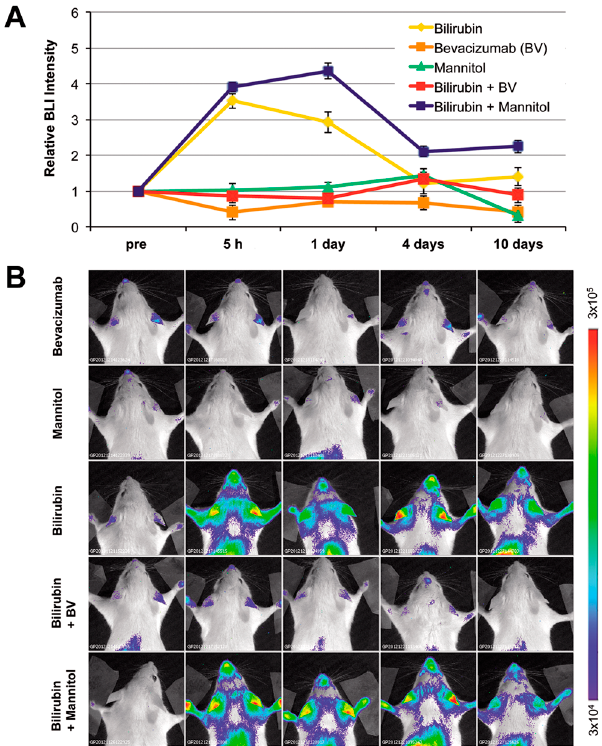
Figure 5. Effect of alteration of blood–brain barrier permeability. Before bilirubin administration, MITO-Luc mice were pretreated with mannitol (3 mL of 25% mannitol/100 g body weight) or bevacizumab (25 mg/kg body weight) and bioluminescence imaging analysis (BLI) was performed at different time points. ( A ) Quantification of BLI signals in selected regions of interest in the brain area. Statistical analysis revealed significant differences ( p ≤ 0.05) of the bilirubin group vs. bilirubin + bevacizumab group at the 5 h and 1 day time points; ( B ) BLI analysis of one representative animal out of five per group, at the different time points. The color bar and numbers illustrate the relative bioluminescent signal intensities from the lowest (blue) to the highest (red), with minimal and maximal values expressed in photons/s/cm 2 /sr.